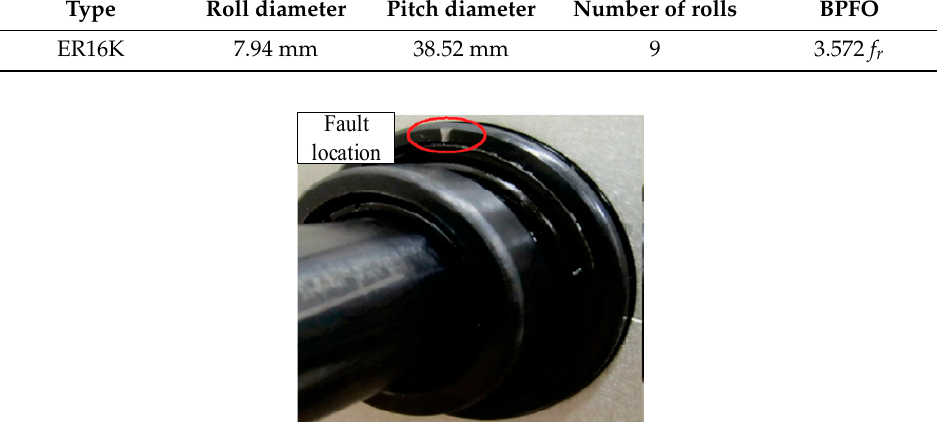
Table 3. The related parameters of the outer fault bearing. Ball Pass Frequency Outer Race (BPFO).